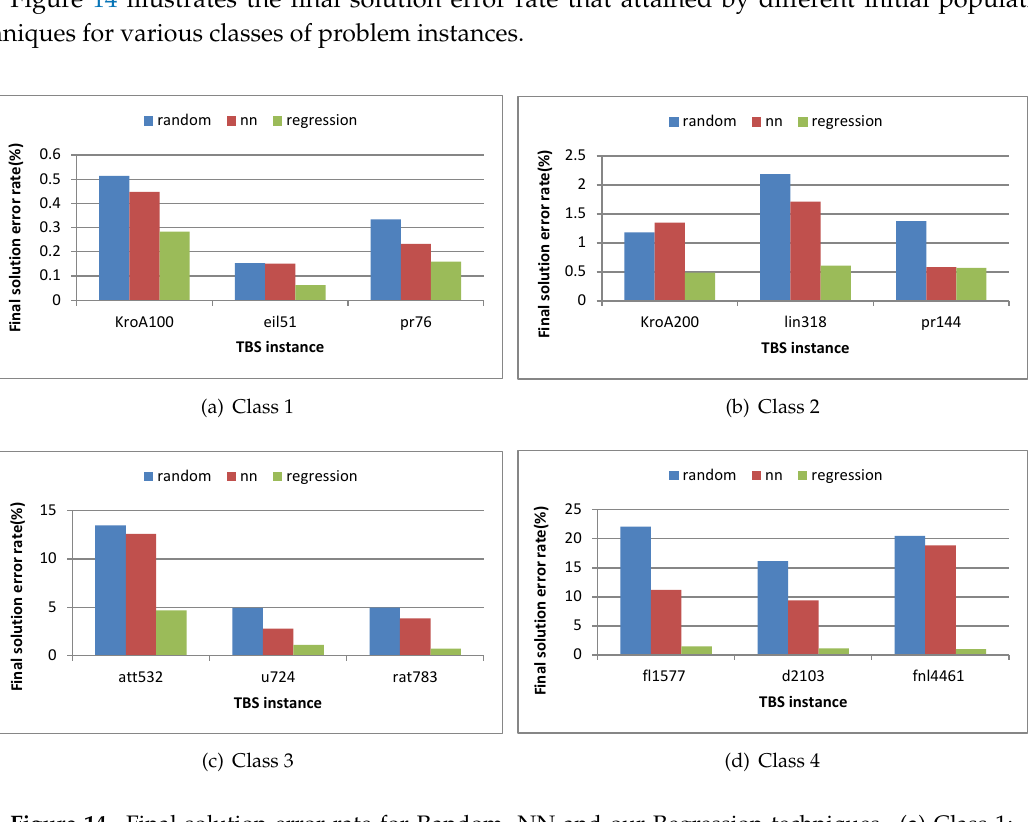
Figure 14. Final solution error rate for Random, NN and our Regression techniques. ( a ) Class 1; ( b ) Class 2; ( c ) Class 3; ( d ) Class